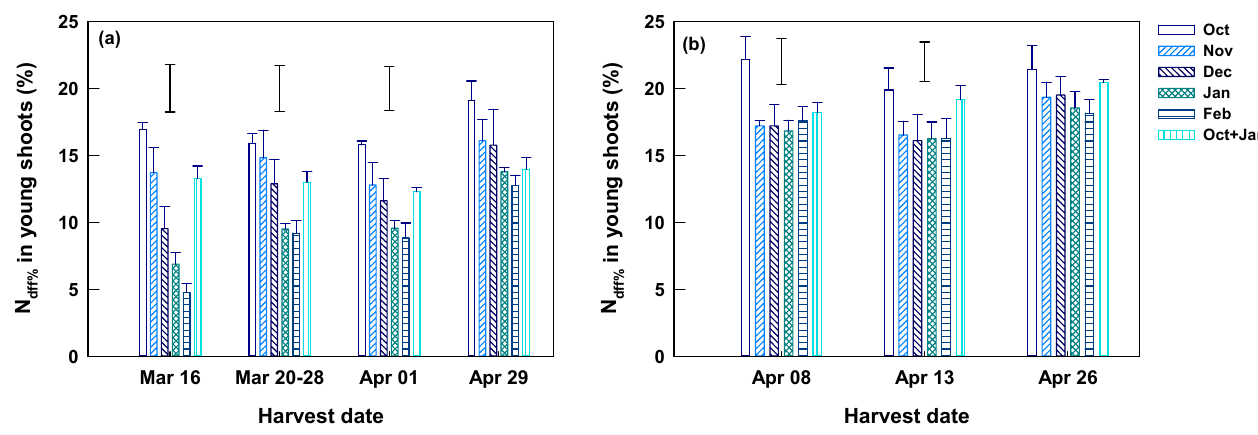
Figure 5. N dff% of spring young shoots harvested on different dates at Yongchuan ( a ) and Xingyang ( b ) from tea plants receiving 15 N enriched urea individually in October, November, December, Janauary, and February and split in October and January. Data are means and SE ( n = 4). Bars without data points above columns represent LSD values indicating significant ( p < 0.05) difference among fertilization dates on each of the specified harvest dates. Table 3. Mean N concentration and N dff% of young shoots across fertilization dates.